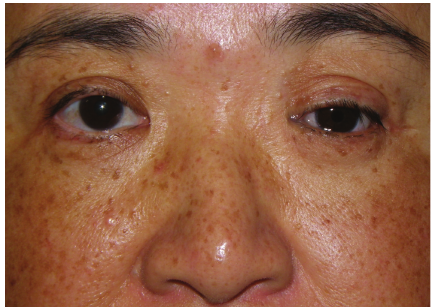
Figure 1: Preoperative view of Case 1.